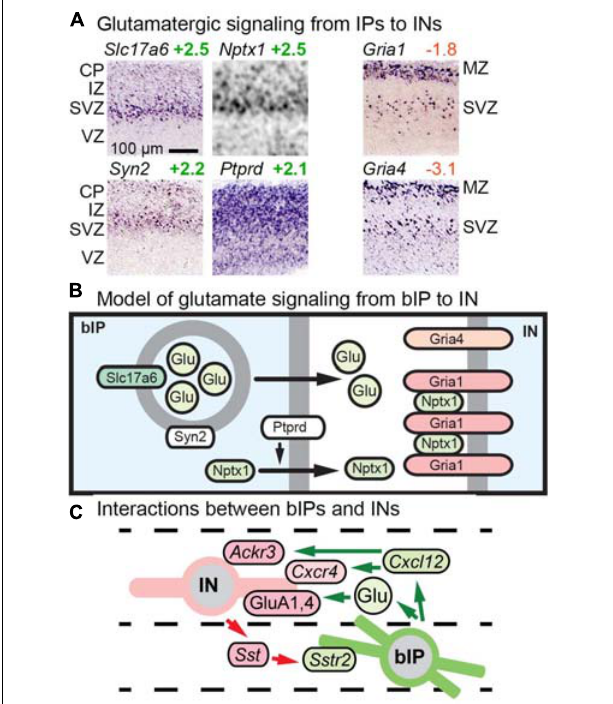
FIGURE 7 | Glutamate signaling and other bIP-IN interactions. (A) bIPs in the SVZ express molecules for glutamatergic signaling including Slc17a6 (VGLUT2), Nptx1 , Syn2 , and Ptprd ; while migrating INs express AMPA receptors ( Gria1 , Gria4 ). (B) Proposed model for glutamatergic signaling from bIPs to INs. Interestingly, bIPs produce Nptx1 , a secreted protein that clusters AMPA receptors. (C) Glutamate signaling is one of several interactions between IPs and